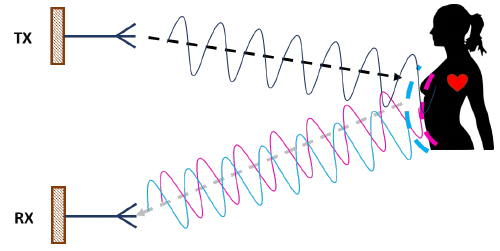
Figure 1. Bio-radar working